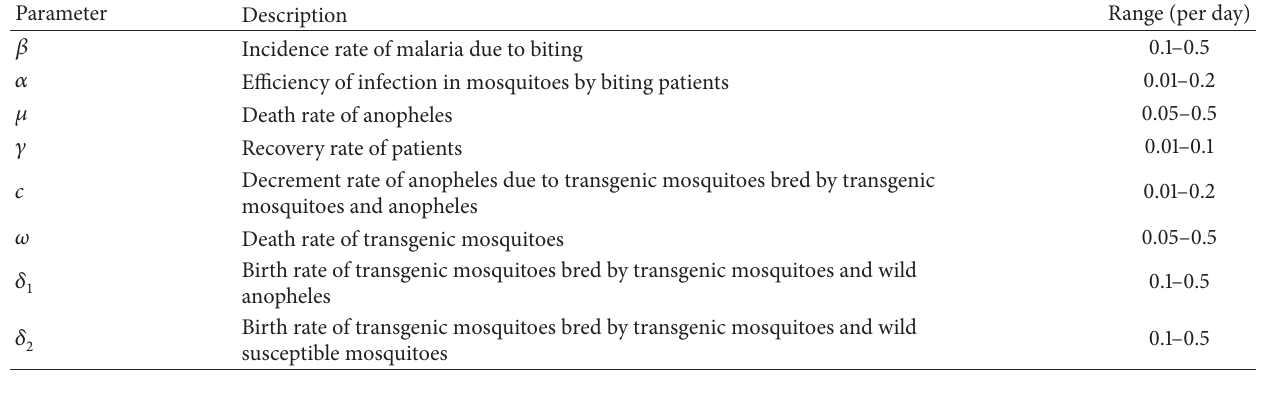
Table 3: Ranges of the parameters in system (11).